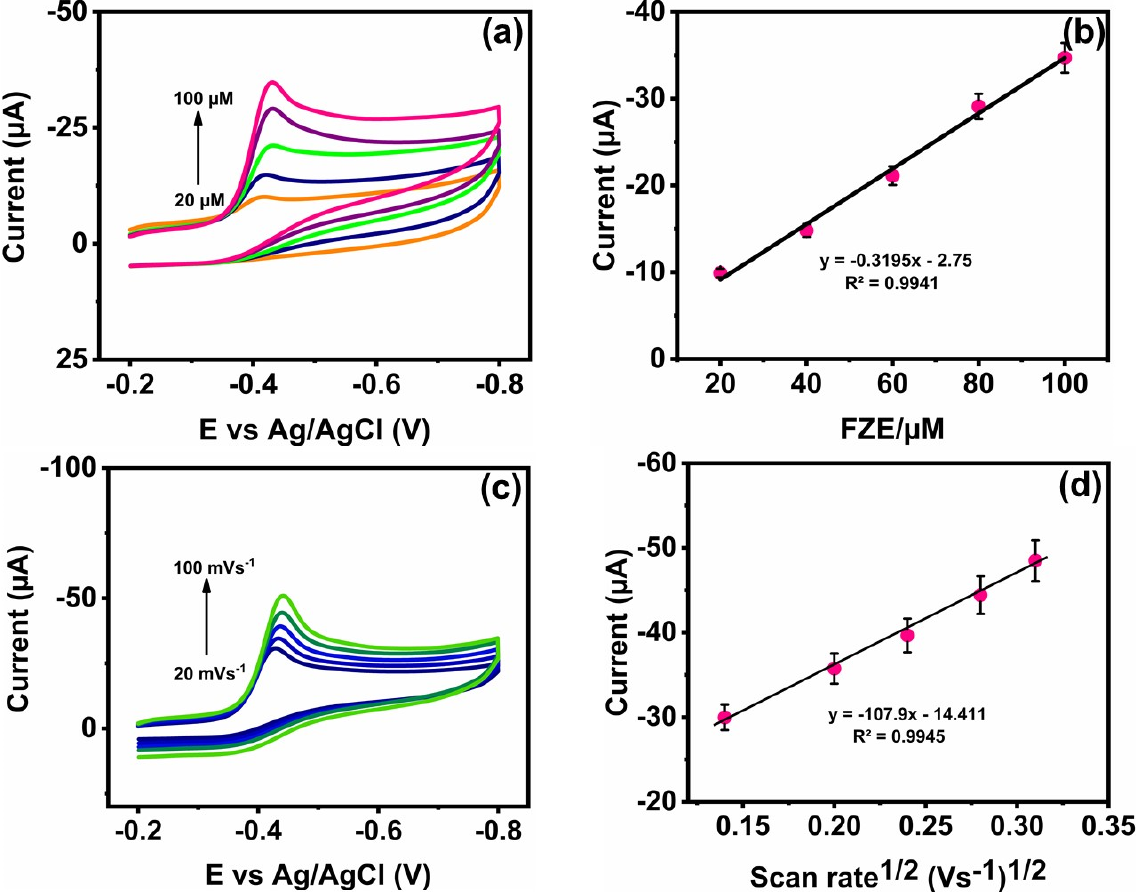
Figure 8. ( a ) CV response of different concentrations of FZE (20–100 µM) at NMO/GCE in (pH-7) at a scan rate of 50 mVs − 1 and ( b ) the linear plot of concentrations of FZE vs. reduction current, ( c ) CV response of various scan rates (20–100 mVs − 1 ) at NMO/GCE containing 100 µM of FZE (pH-7) and ( d ) a linear plot for the square root of the scan rates vs. the reduction in the current response. The kinetic electrochemical performance of NMO/GCE was examined at various scan rates with 100 µM of FZE at a scan rate of 20 − 100 mVs − 1 , shown in Figure 8c. Based on the observation, when the scan rate increased, the reduction peak current also increased. Ad- ditionally, Figure 8d shows the linear plot for the reduction peak current and the square root of scan rates and displays a linear regression equation and co-efficient value of I pc = − 107.9x − 14.411 and R 2 = 0.9945, respectively.